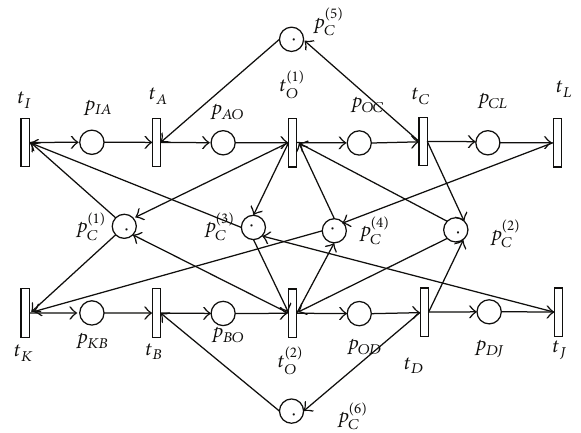
Figure 10: Type III protection-zone conflict-control